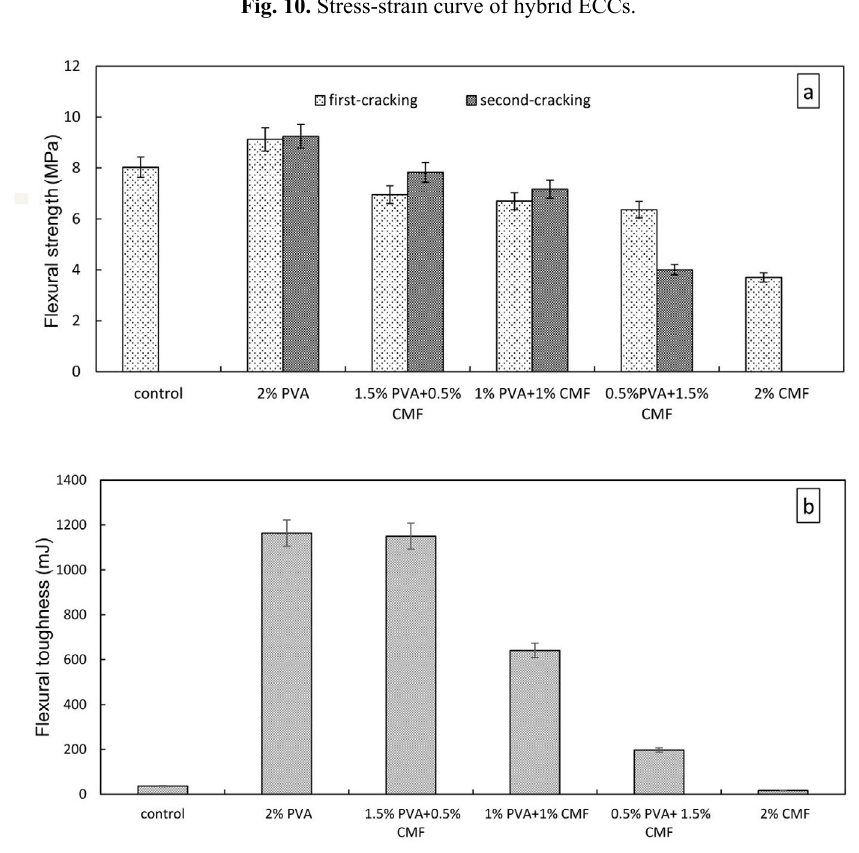
Fig. 11. The flexural properties of hybrid